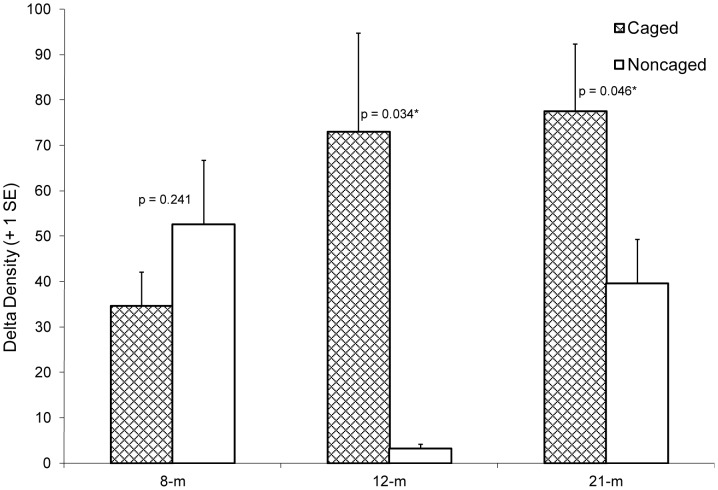
Mean delta density of newly settled stages of Haemulon species on the caged and noncaged ARs at each site.P-values obtained from comparison of caged and noncaged ARs for each site (difference between two means test). Significant p-values between treatments at a site denoted with asterisk (*).